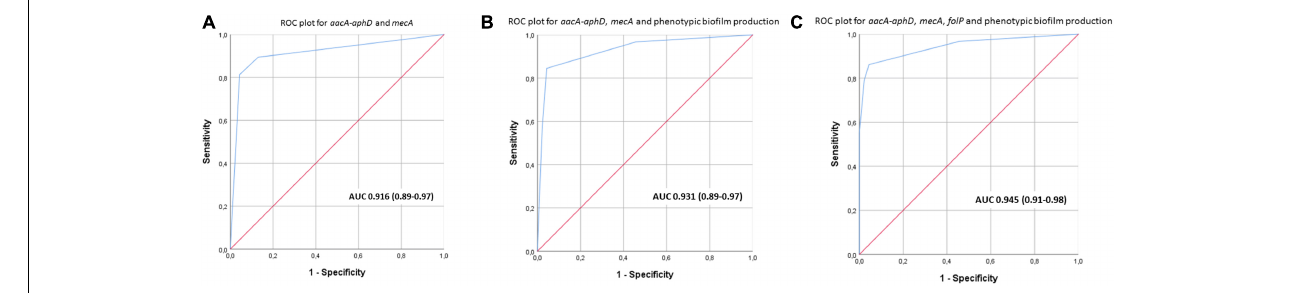
FIGURE 5 | (A–C) Receiver operating characteristics (ROC) curves with area under curve (95% confidence interval) for scores using different combinations of aacA-aphD , mecA , folP and phenotypic biofilm production in order to discriminate between clinical and commensal isolates. S. haemolyticus are the major sources of infections, and that skin contamination is less likely (Tognetti et al., 2012; Kaspar et